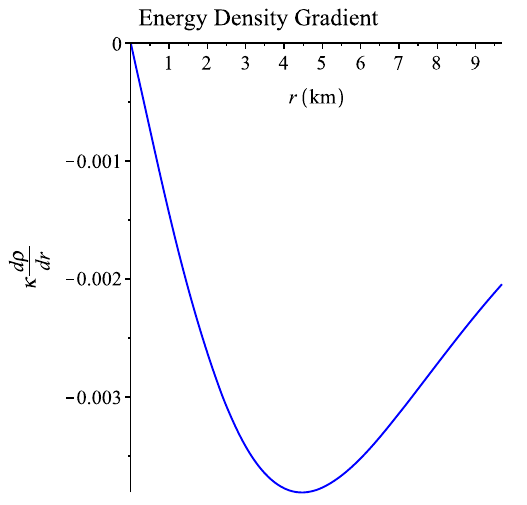
Fig. 7 Plot of the speeds of adiabatic sound for the parameter values used in Fig. 1. The solid (blue) line corresponds to v r = the dashed (red) line corresponds to v t = line indicates that d P r / d ρ ≈ constant, and the equation of state (Fig. 6) is almost linear